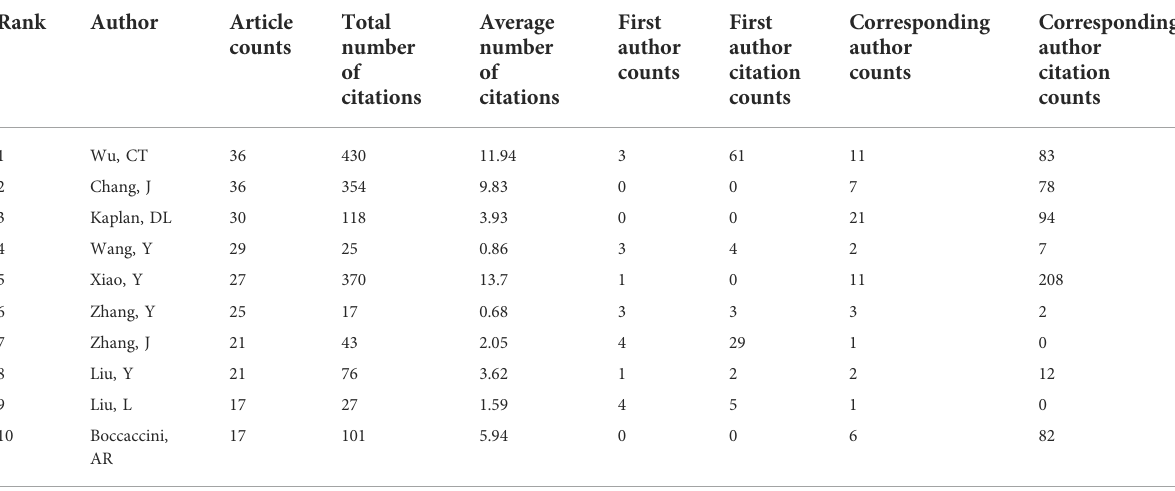
were used to visualize the relationship between publications and high-frequency keywords (Figure 6). The matrix graph was shown in Figure 6A, where column labels represented papers and row labels represented keywords. To combine similar rows into a single cluster, the rows of the initial matrix graph were reset, and each cluster was split by horizontal lines. In the matrix graph, the upper dendrogram represented paper association, and the left represented high-frequency keyword association. The results of the volcano graph in Figure 6B directly characterized the data as fi ve different mountains representing fi ve different clusters numbered from 0 to